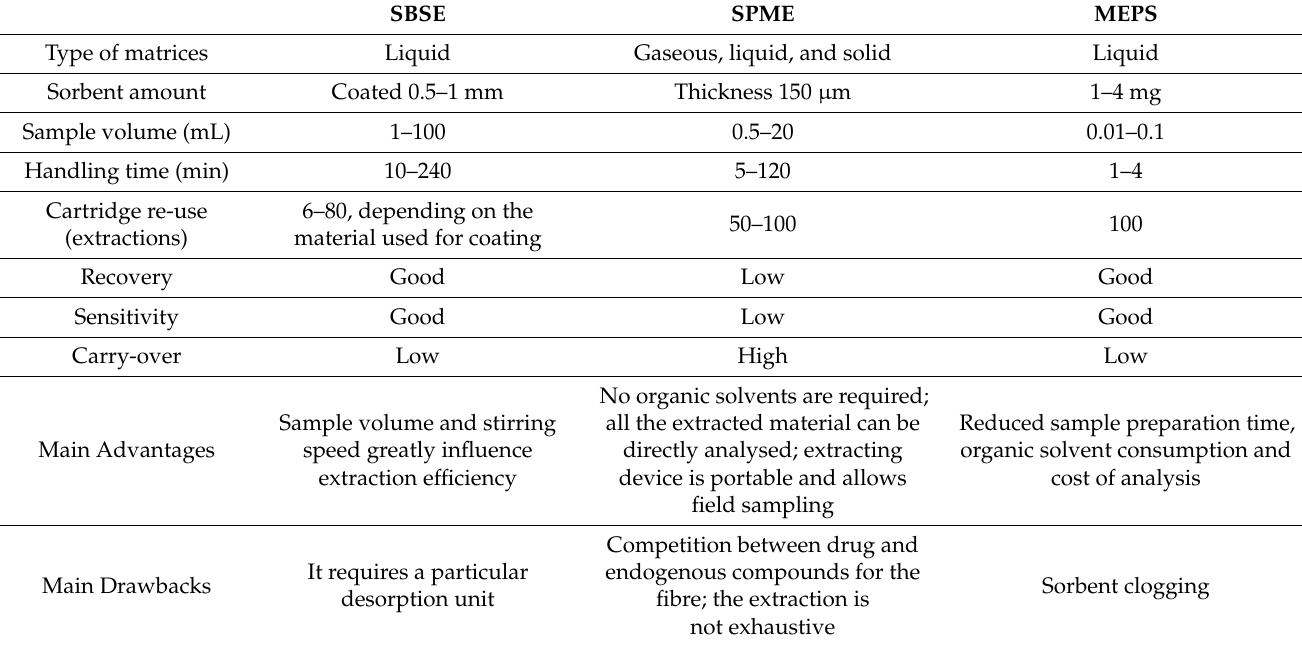
Table 3. Comparing with other miniaturized techniques, adapted from